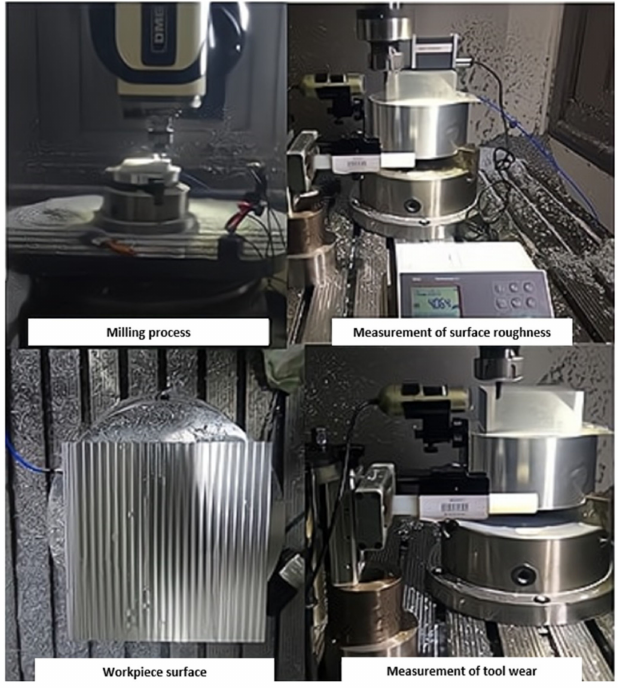
Figure 7. Experiment environment and measurement.